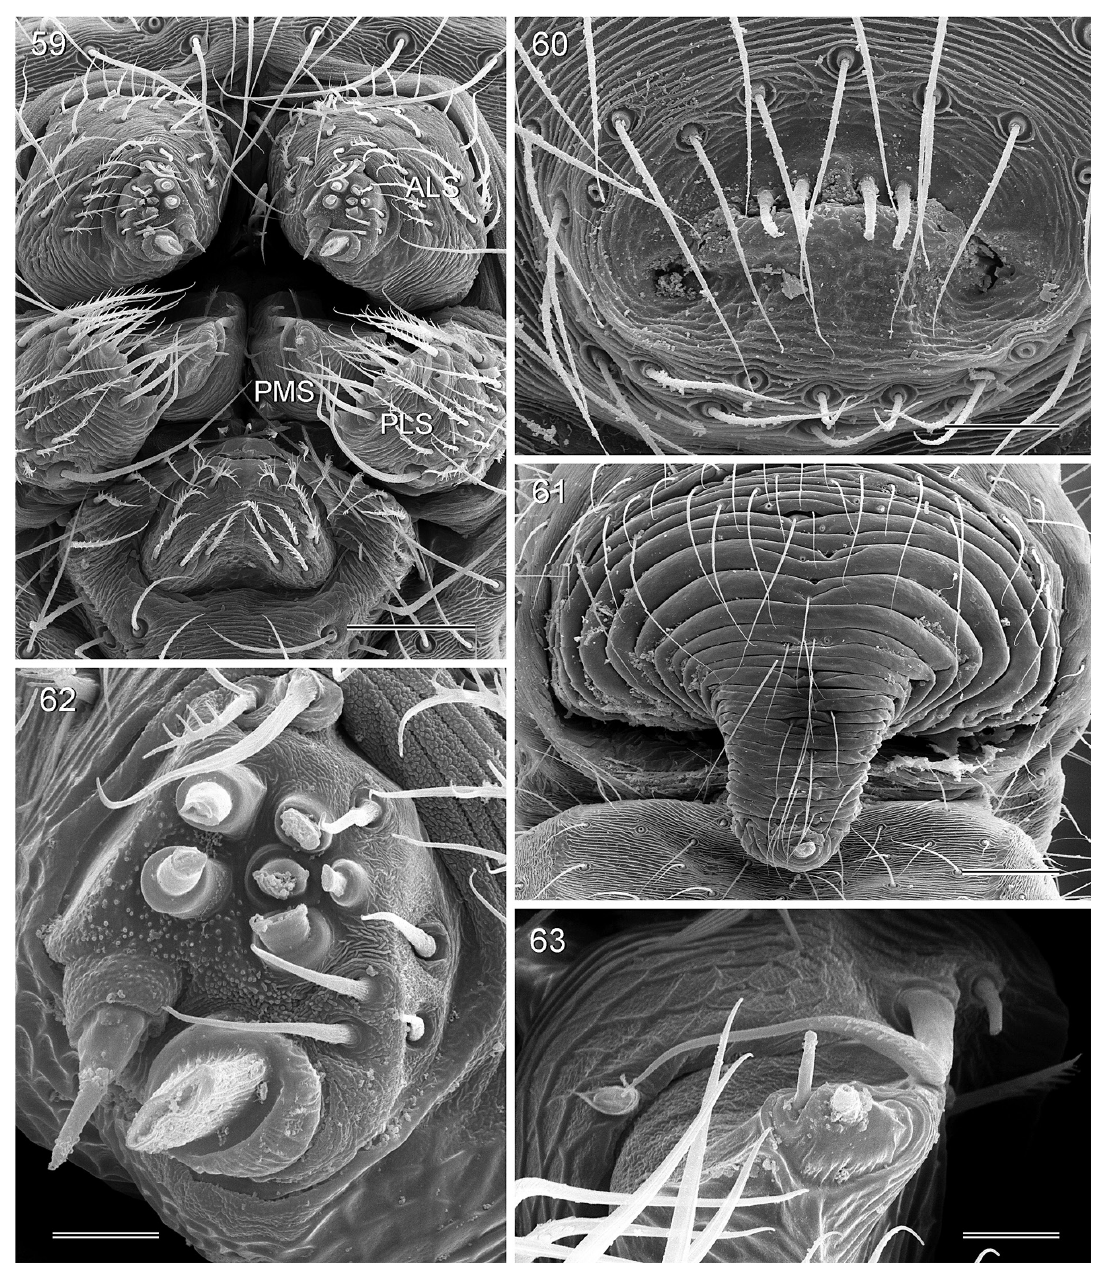
Figs 59–63. Panjange camiguin Huber sp. nov., SEM micrographs (ZFMK, Ar 13003, 13004). 59 . Female spinnerets. 60 . Male gonopore. 61 . Epigynum and scape, ventral view. 62 . Female ALS. 63 . Female PMS. Abbreviations: ALS = anterior lateral spinneret; PLS = posterior lateral spinneret; PMS = posterior median spinneret. Scale bars: 59 = 60 µm; 60 = 30 µm; 61 = 100 µm; 62–63 = 10